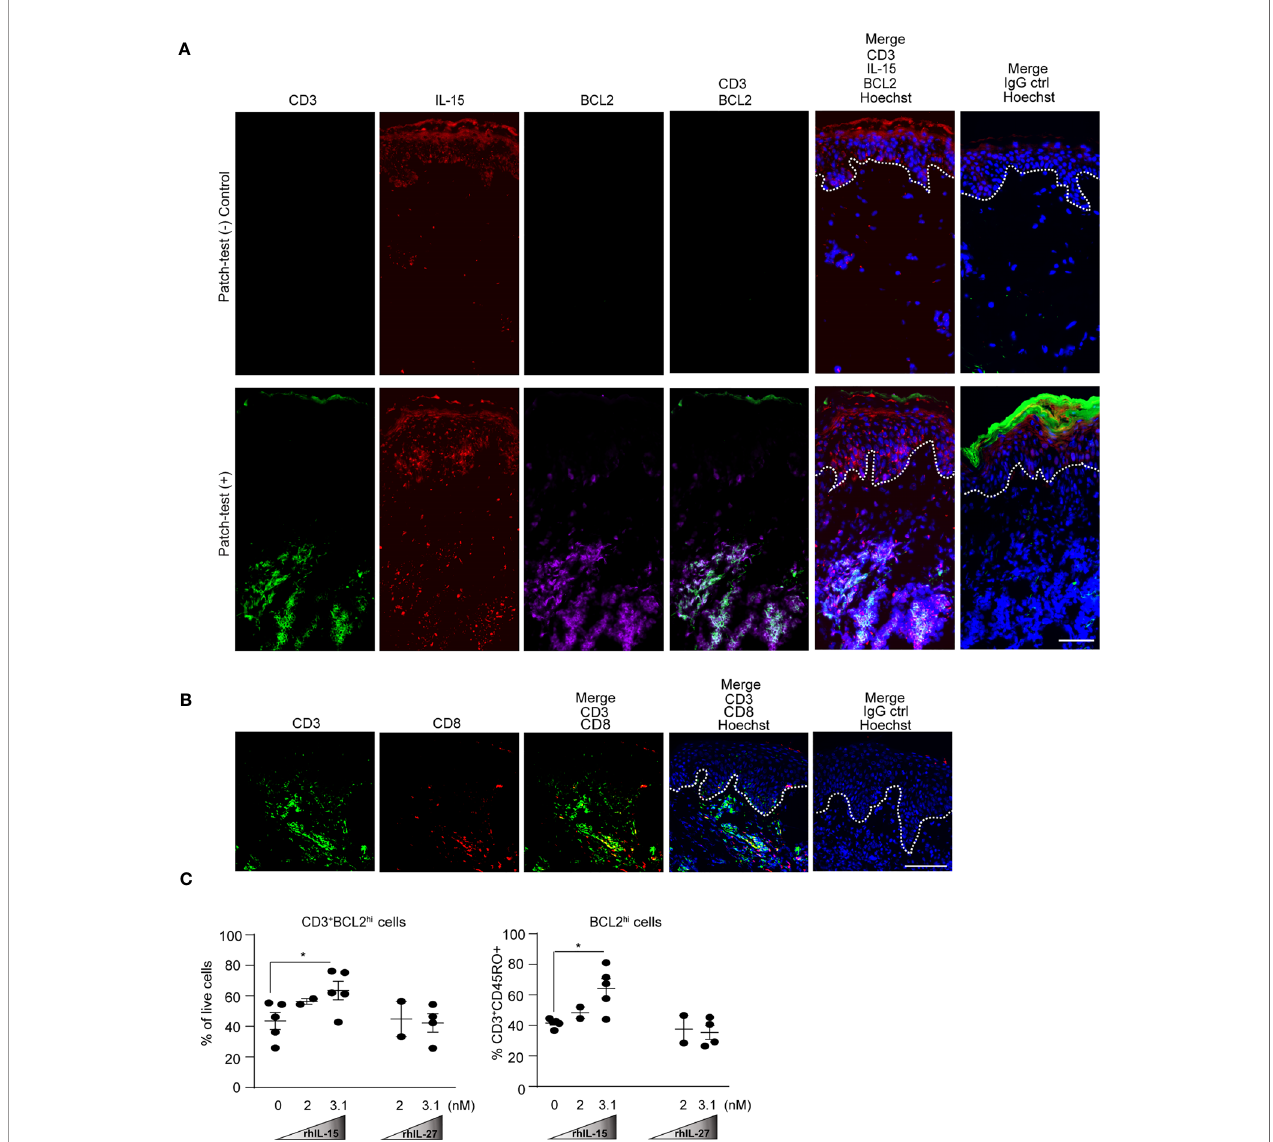
FIGURE 7 | IL-15 enhances human BCL2 expression in skin T cells. (A) Representative immuno fl uorescence staining of CD3 (green), IL-15 (red), BCL2 (purple), and Hoechst (blue) in human donor-matched patch-test negative control and patch-test (+) ACD skin. Data are representative of patient samples per tested condition (at least 3 samples per condition). Original magni fi cation x400 (stitched images) with scale bars of 100 µm. White dashed lines mark the epidermal-dermal junction. (B) Representative immuno fl uorescence staining of CD3 (green), CD8 (red), and Hoechst (blue) in human patch-test (+) ACD skin. Data are representative of patient samples per tested condition (at least 3 samples per condition). Original magni fi cation x400 with scale bars 100 µm. White dashed lines mark the epidermal-dermal junction. (C) Quanti fi cation of fl ow cytometry analysis of healthy human skin explant T cells treated with rhIL-15 and rhIL-27 for 24 hours. Cells were gated on live cells and CD3 + CD45RO + cells subsequently gated on CD3 + BCL2hi and BCL2hi cells, respectively. Data are summarized as mean ± SEM, *p < 0.05 (paired Student ’ s t